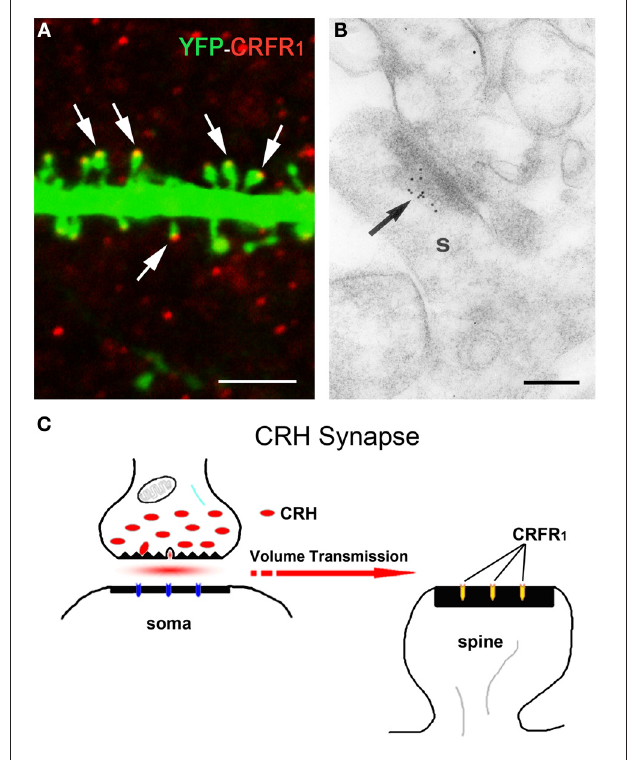
FIGURE 3 | The post-synaptic location of the CRH receptor CRFR 1 on dendritic spines. (A) The CRH receptor CRFR 1 (red) is located at the dendritic spine heads, as shown by confocal microscopy of CA3 pyramidal neuronal dendrite (green) from a YFP-expressing mouse. Arrows denote spine heads expressing the receptor. (B) Electron micrograph showing CRFR 1 -immunogold particles (arrow) concentrated at the post-synaptic density (PSD) of an asymmetric (excitatory) synapse on a dendritic spine (s) in stratum oriens of hippocampal area CA3. Very few gold grains were observed elsewhere. (C) A cartoon depicting the concept of the mis-matched CRH synapse: pre-synaptic elements (axon terminal and boutons) are GABAergic ( Figure 1 ), whereas post-synaptic elements on dendritic spines are consistent with excitatory synapses ( Figure 3A ). CRH that is released from inhibitory pre-synaptic elements may migrate via volume transmission and act on the CRFR 1 receptor at relatively distant excitatory post-synaptic sites. Scale bars = 3 μ m (A) , 0.1 μ m (B) . Reproduced, with permission, from Chen et al. (2010) (A) , (2004b) (B)